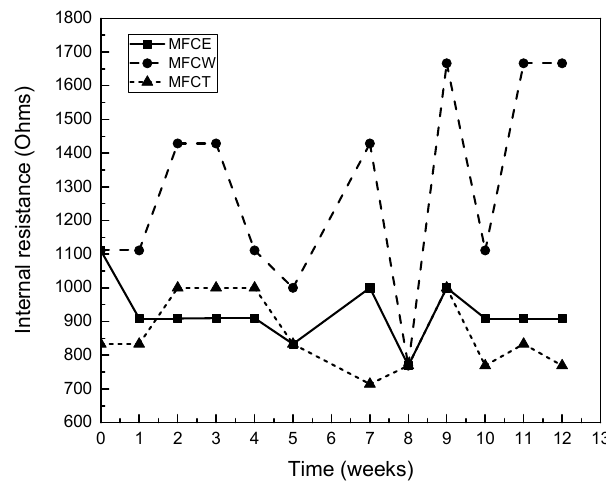
Figure 3. Internal resistance of the MFCs.